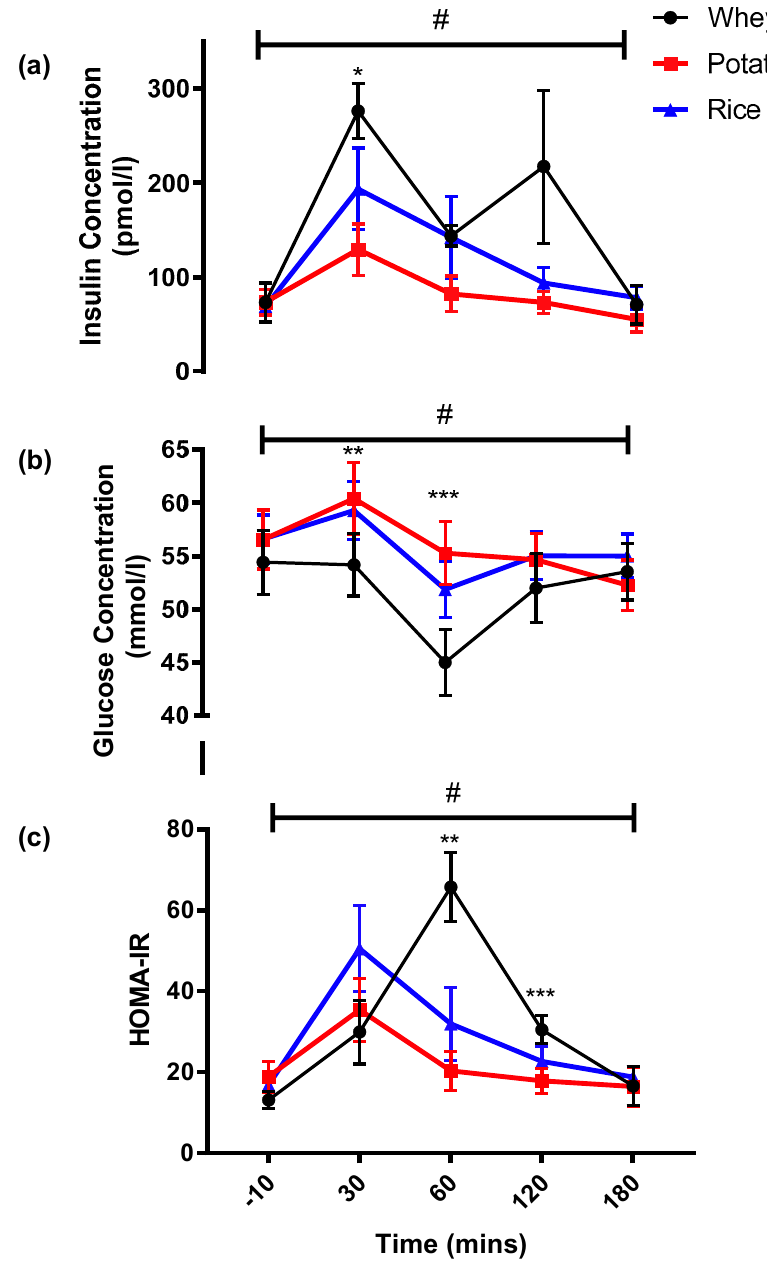
Figure 2. ( a ). Blood Insulin concentrations, ( b ) Blood Glucose concentrations and ( c ) HOMA-IR observed across the three experimental conditions. * Potato is significantly different to both conditions ( p < 0.05). ** Whey is significantly different to both conditions ( p < 0.05). *** Whey is significantly different from potato only ( p < 0.05). # Shows that significance was present with time ( p < 0.05).